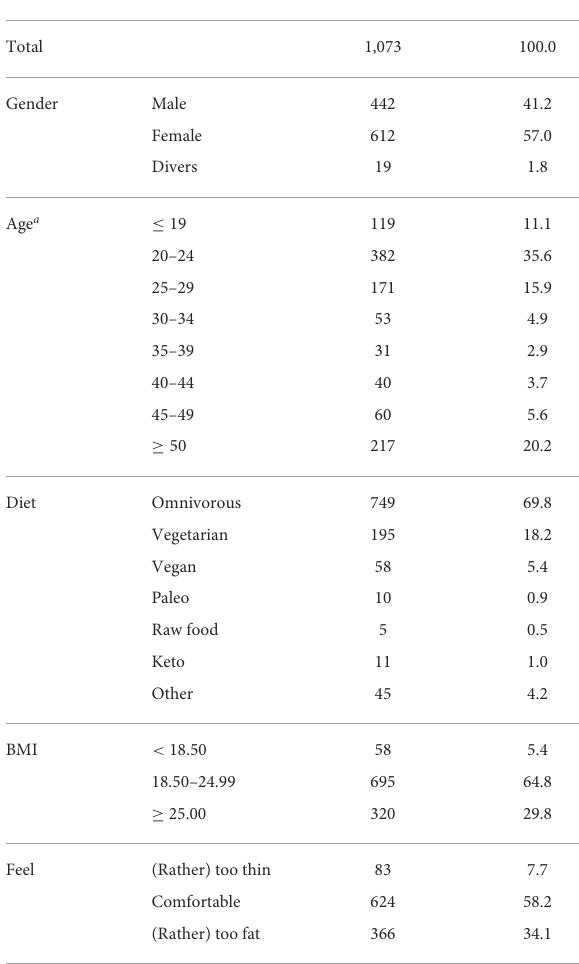
TABLE 1 Characteristics of study participants. TABLE 2 Fit index values for the tested models ( n =